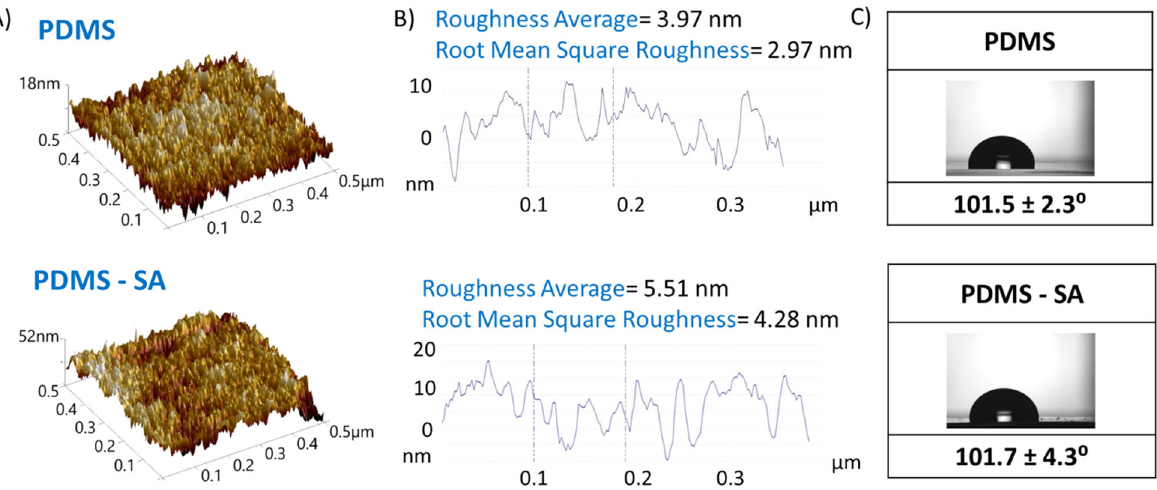
Fig. 2 Surface properties of PDMS and PDMS-SA samples. A AFM images showing the topography of the surfaces. B Surface pro fi le and roughness of the surfaces obtained from AFM data. C Water contact angle at the